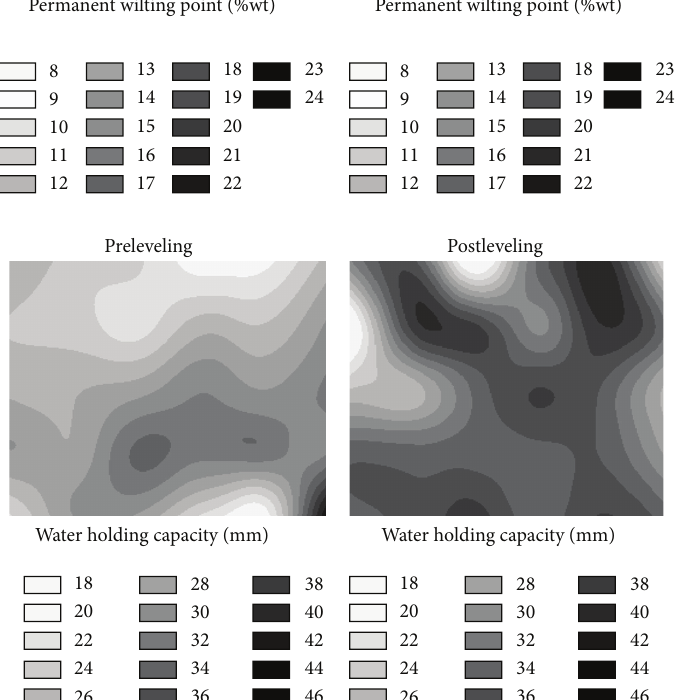
Figure 7: Pre- and post-leveling spatial distributions of soil field capacity, permanent wilting point, and water holding capacity for subsurface soil